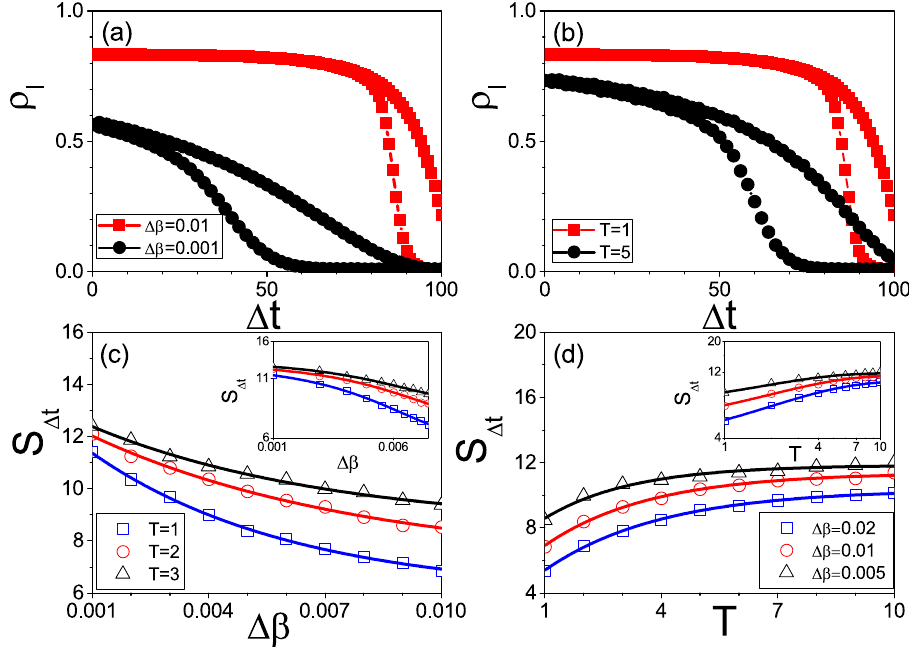
Figure 9. Hysteresis loops in state space for the case of SF network. ( a ) ρ I versus Δ t for fixed T = 1 where the curves with “squares” and “circles” represent the cases of Δ β = 0.01 and 0.001, respectively. ( b ) ρ I versus Δ t for fixed Δ β = 0.01 where the curves with “squares” and “circles” represent the cases of T = 1 and 5, respectively. ( c ) S Δ t versus Δ β where the curves with “squares”, “circles” and “triangles” represent the cases of T = 1, 2 and 3, respectively. The inset shows the log-log plot. ( d ) S Δ t versus T where the curves with “squares”, “circles” and “triangles” represent the cases of Δ β = 0.02, 0.01 and 0.005, respectively. The inset shows the log-log plot.